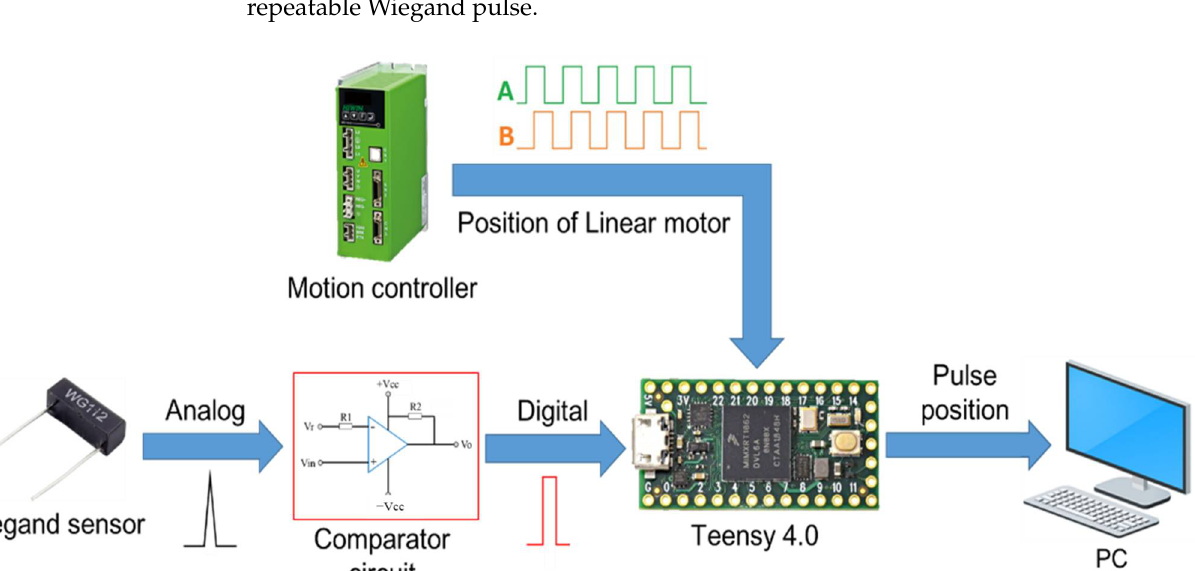
Figure 4. Dimensions of the commercial WG112 Wiegand sensor used in this research.